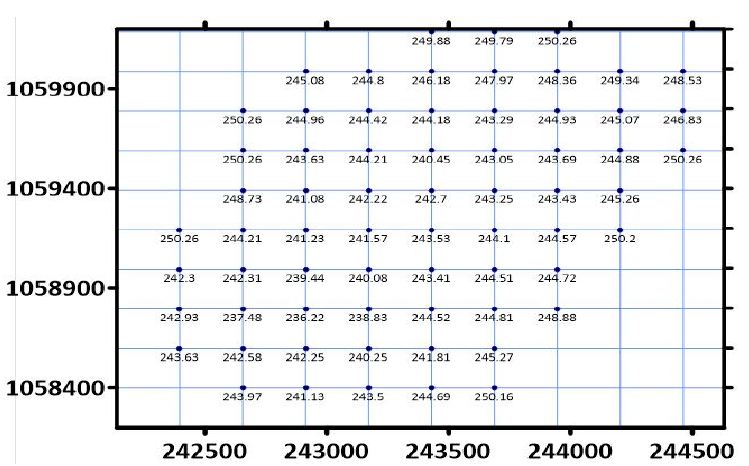
Figure 3. Spatial leapfrog positions in blue (Source: Research lab).